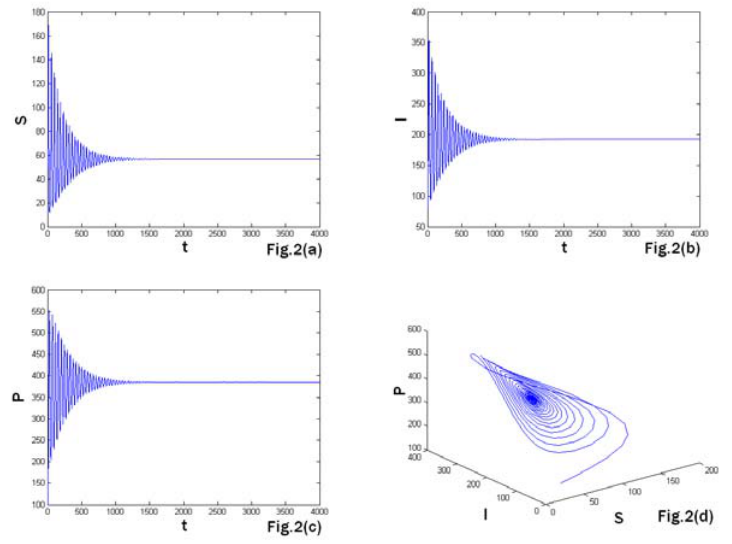
Figure 2. Time evolution of all the population for the model (1.2) with τ = 0 . 5 and initial value (50,80,100). (a), (b) and (c) are S , I and P versus t , respectively. And (d) is the projected S − I − P phase plane.